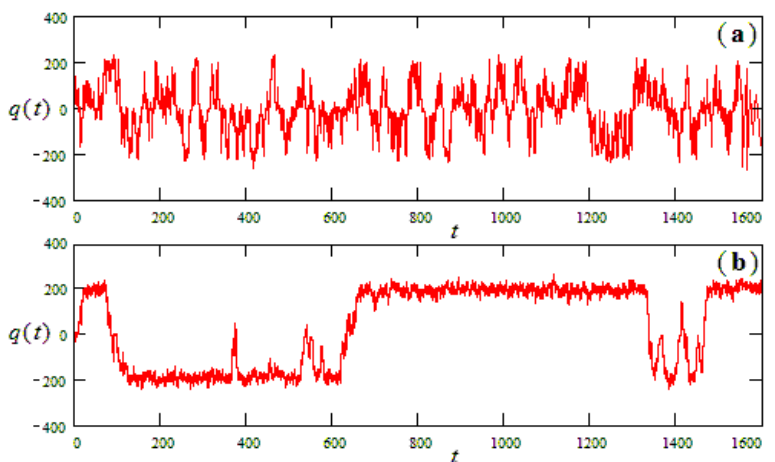
Figure 10: Temporal evolution of the order parameter q ( t ) for the Gillespie stochastic simulation: (a) the monomer case; (b) the multimer case.